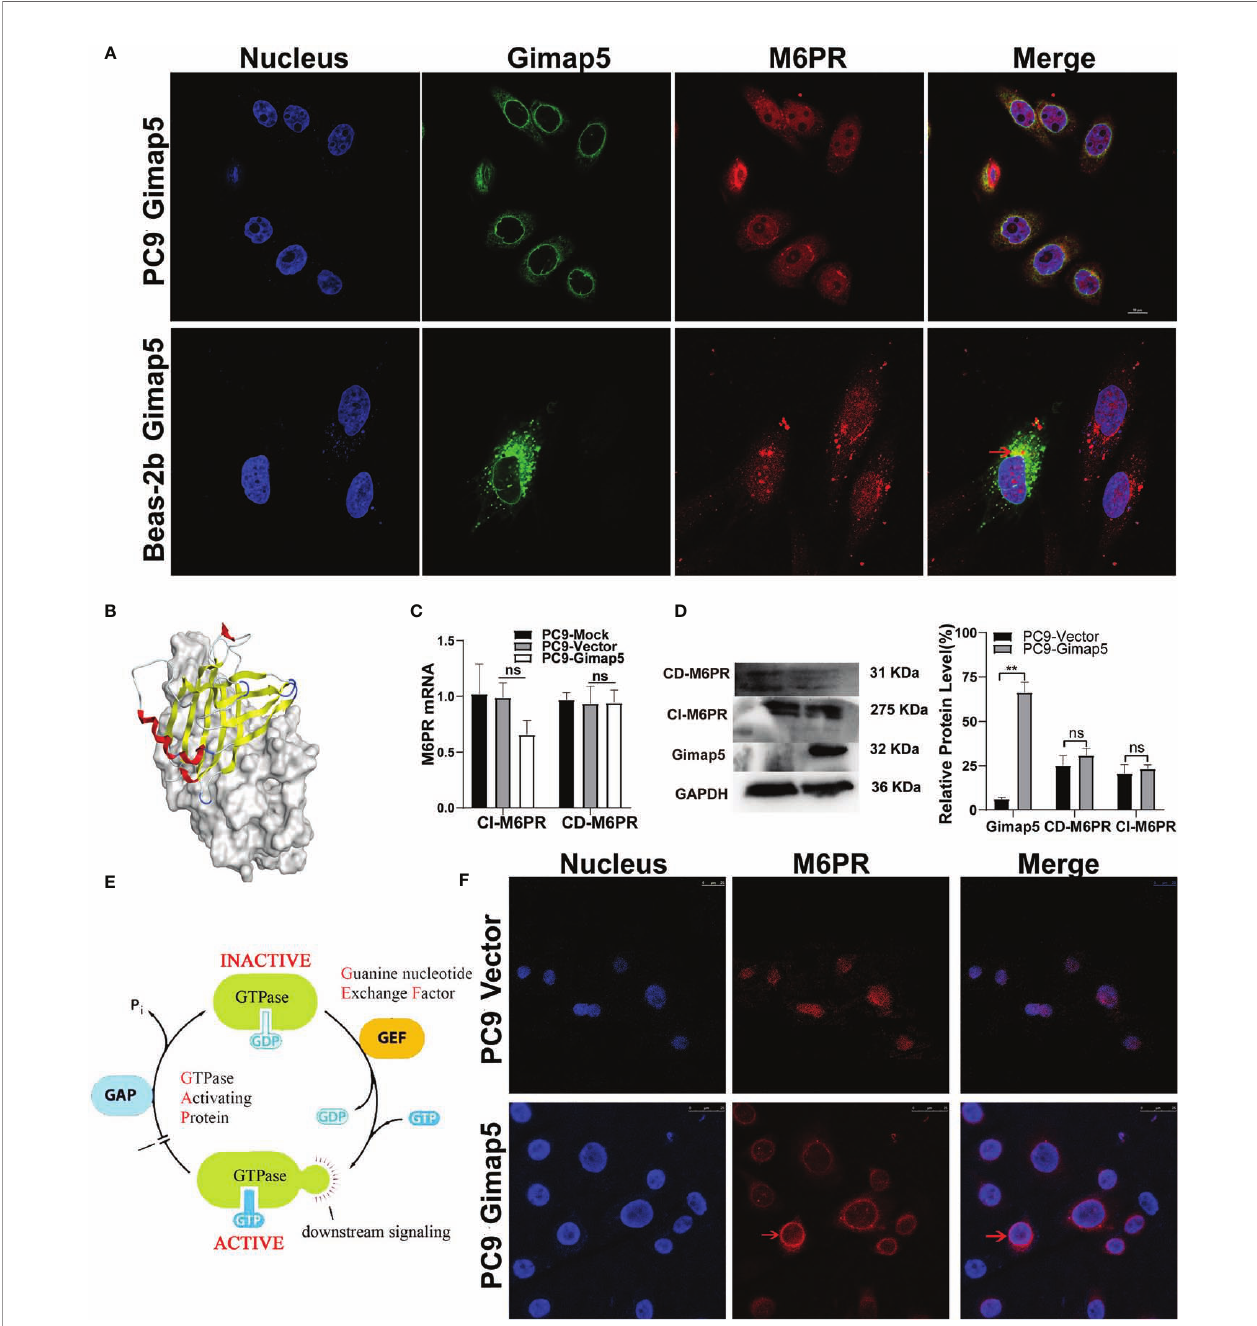
FIGURE 6 | Gimap5 altered the distribution of M6PR on the lung cancer cells surface. (A) The co-location of Gimap5 and M6PR were examined in PC9-Gimap5 cells and Beas-2b-Gimap5 cells. (magni fi cation, × 1000). (B) Molecular docking diagram of Gimap5 and M6PR. (C) The effect of Gimap5 overexpression on the transcription level of M6PR (ns means no signi fi cance). (D) The effect of Gimap5 overexpression on the protein level of M6PR. After the image scanning gray analysis, the internal reference GAPDH correction was used to obtain the ratio of each group (ns means no signi fi cance; ** p < 0.01 vs. empty vector). (E) Pattern diagram of action mechanism of GIMAP5 GTPase. (F) Gimap5 altered the intracellular distribution of M6PR (magni fi cation, ×